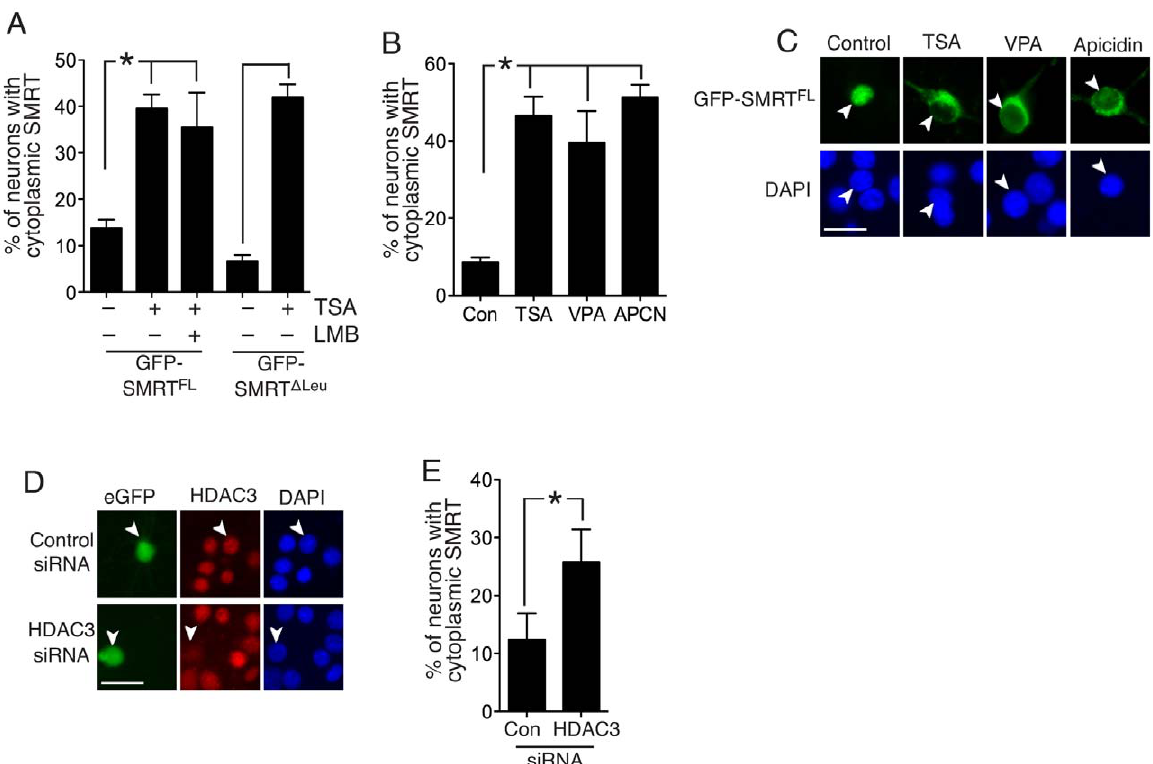
Figure 1. Inhibition of class I HDAC and knockdown of HDAC3 is sufficient to promote SMRT export. A ) GFP-SMRT FL export is insensitive to Leptomycin B and to mutation of a leucine-rich potential nuclear export sequence. Neurons were transfected with plasmids encoding GFP-SMRT FL or GFP-SMRT D Leu and treated, where indicated with Leptomycin B (20 ng/ml) for 1 h prior to treatment with TSA. Note that although redistribution was observed after 1–2 h treatment with TSA and other HDAC inhibitors, the effect observed was greater after 6–8 h and so all data presented in this manuscript relates to treatment with the indicated drugs for this time. * p , 0.05 (n=4). B) Neurons were transfected with plasmids encoding GFP- SMRT FL and 48 h after transfection the neurons were treated with TSA, VPA or Apicidin and the cellular localization of GFP-SMRT FL was analyzed. * p , 0.05 (n=3). C) Examples of the cellular localization of GFP-SMRT FL after treatments with the indicated HDAC inhibitors. Scale bar is 20 m m here and throughout the manuscript. D) Example pictures to demonstrate the efficacy of HDAC3-directed siRNA in knocking down endogenous HDAC3 expression in rat cortical neurons. Neurons were transfected with the siRNAs as indicated, plus peGFP to identify transfected cells. After 72 h, cells were fixed and HDAC3 expression analysed by immunofluorescence. White arrows point to transfected neurons. E) HDAC3 siRNA causes redistribution of SMRT to the cytoplasm. Neurons were transfected with plasmids encoding GFP-SMRT FL plus siRNA as indicated. SMRT localization was studied 72 h post-transfection. * p , 0.05